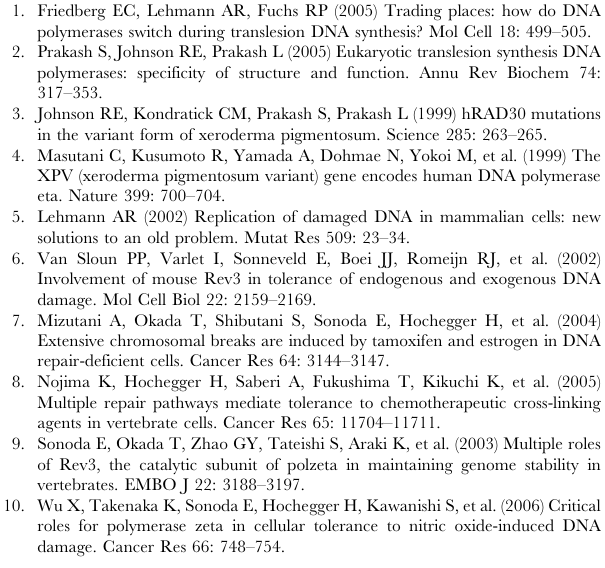
Figure S1 Increased phospholylation of histone H2AX in pol f deficient cells. (A) Fluorescence image of fixed DT40 cells with indicated genotype. Cells were stained with antibody to phospho- Histone H2AX (red) and with DAPI (Blue). (B) Percentage of the